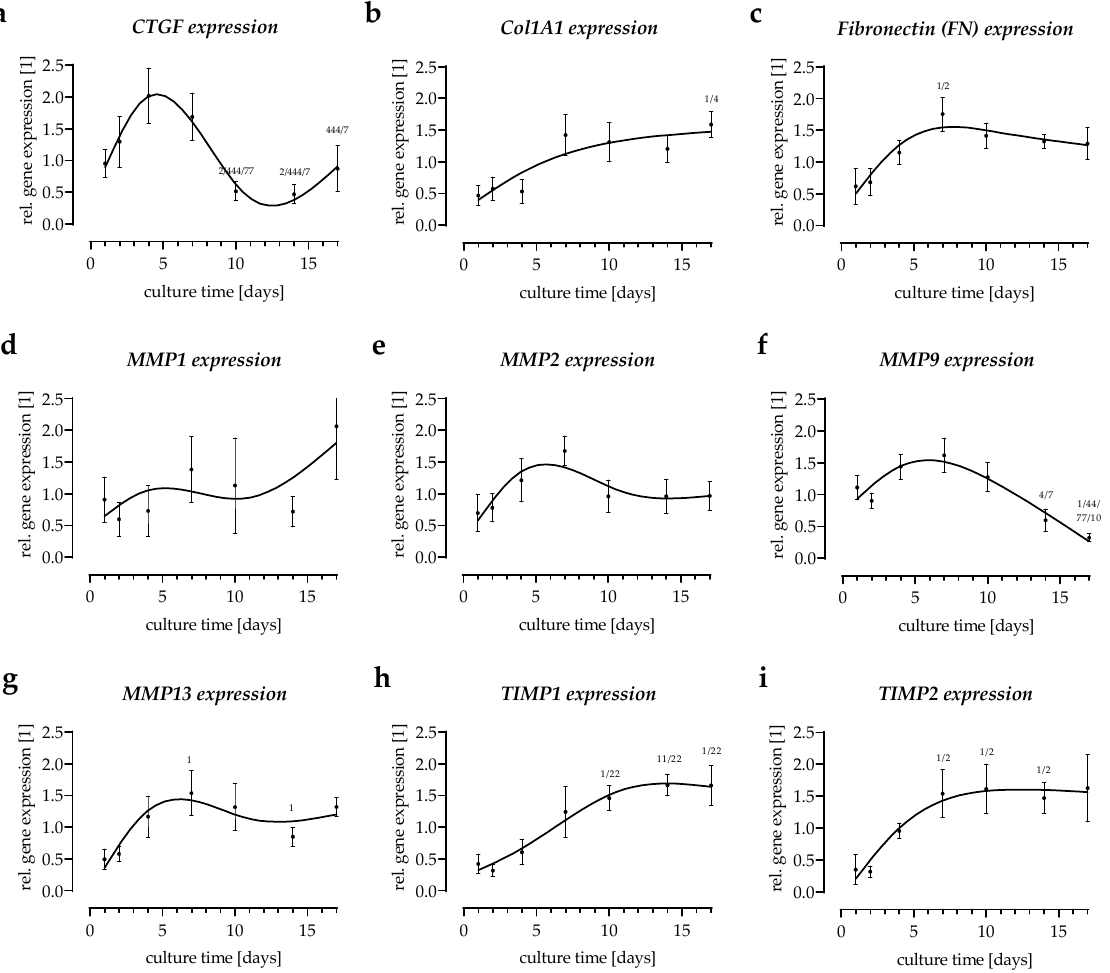
Figure 4. Expression of extracellular matrix-related genes in the in vitro scabs. Gene expression was determined by semi-quantitative RT-PCR on days 1, 2, 4, 7, 10, 14, and 17 of culture. Expression of target genes ( a ) CTGF (connective tissue growth factor), ( b ) Col1A1 (collagen type 1 alpha-1), ( c ) FN1 (fibronectin), ( d – g ) matrix metalloproteinases MMP1 , MMP2 , MMP9 , and MMP13 , ( h , i ) and tissue inhibitor of metalloproteinases TIMP1 and TIMP2 were determined. N = 4, n = 2. X p < 0.05, XX p < 0.01, and XXX p < 0.001 as compared to day X.